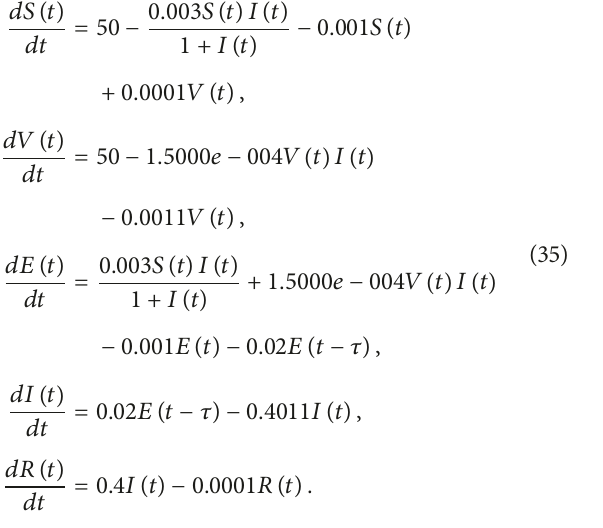
Figure 3: Dynamic behavior of system (35): projection on S-E-R with 𝜏 = 76.65 > 𝜏 0 .